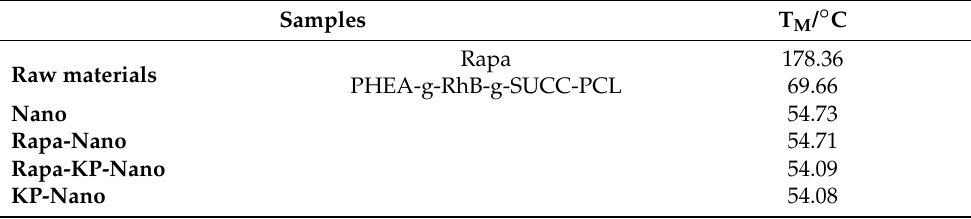
Table 3. Transition temperature values of nanoparticle samples and raw